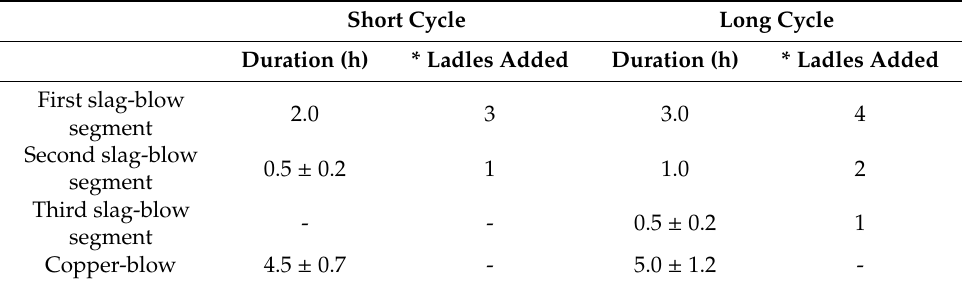
Table 3. Examples of Peirce–Smith (PS) converting data describing short and long